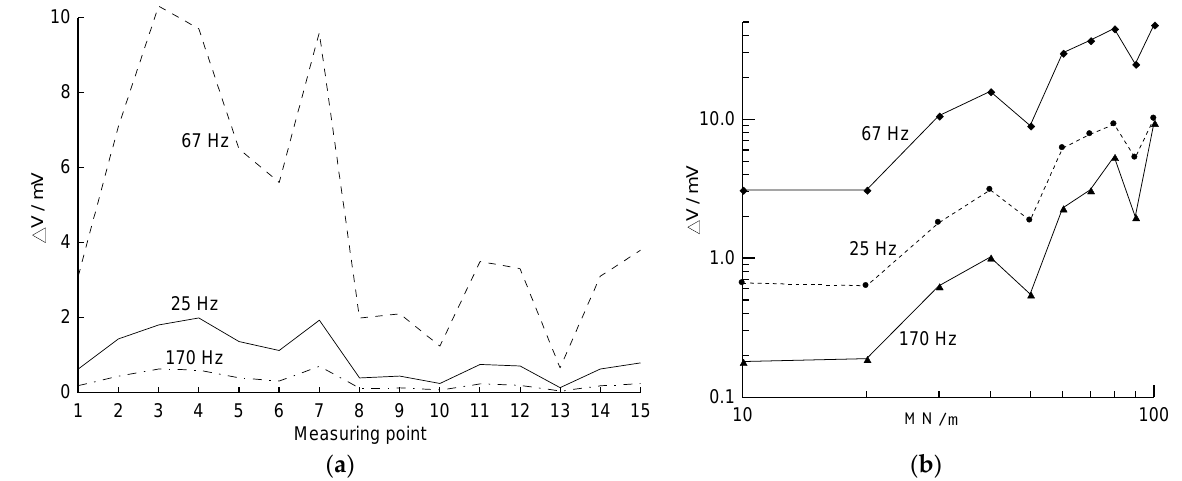
Figure 4. ( a ) Profile survey results and ( b ) sounding results of FSM in Chetian village. The sounding configuration of FSM is similar to the Schlumberger configuration of the conventional vertical electrical sounding method. The measured point lies at O, as shown in Figure 3b, and potential electrodes M and N move outwards synchronously respectively. The increment of electrode spacing is usually 5 m or 10 m, and 1 m in a particular case. The exploration depth increases with the increase of potential electrode spacing MN (Figure 3b) [46–48]. Thus, the variation of potential difference with depth (the potential electrodes spacing MN ) at a certain sounding point can be obtained, and the burial depth of groundwater can be judged according to the sudden variations of potential difference curves with the potential electrodes spacing MN. Figure 4b shows the sounding curves of FSM at point 13 in Figure 4a. The horizontal axis and the vertical axis represent the potential electrodes spacing and the potential difference respectively. The increment of electrode spacing MN is 10 m in Figure 4b. The potential difference ∆ V is generally increase with the gradual enlargement of electrode spacing MN . The obvious inflection point of the sounding curve represents the anomaly, i.e., there may be conductivity anomalous bodies, such as groundwater at the depths reflected by the electrode spacing MN . For example, the anomaly appears near MN equal to 50 m and 90 m in Figure